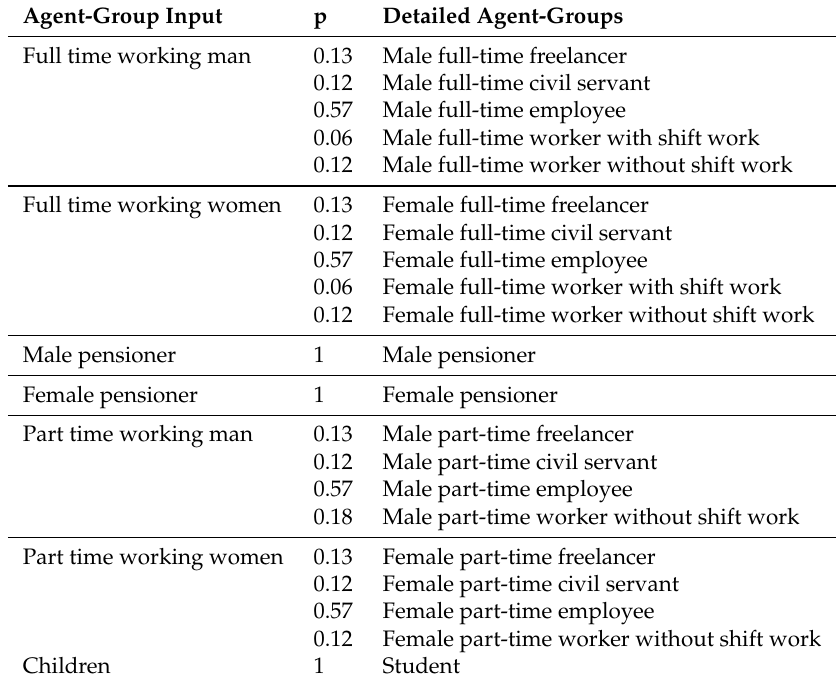
Table 4. Itemisation of the